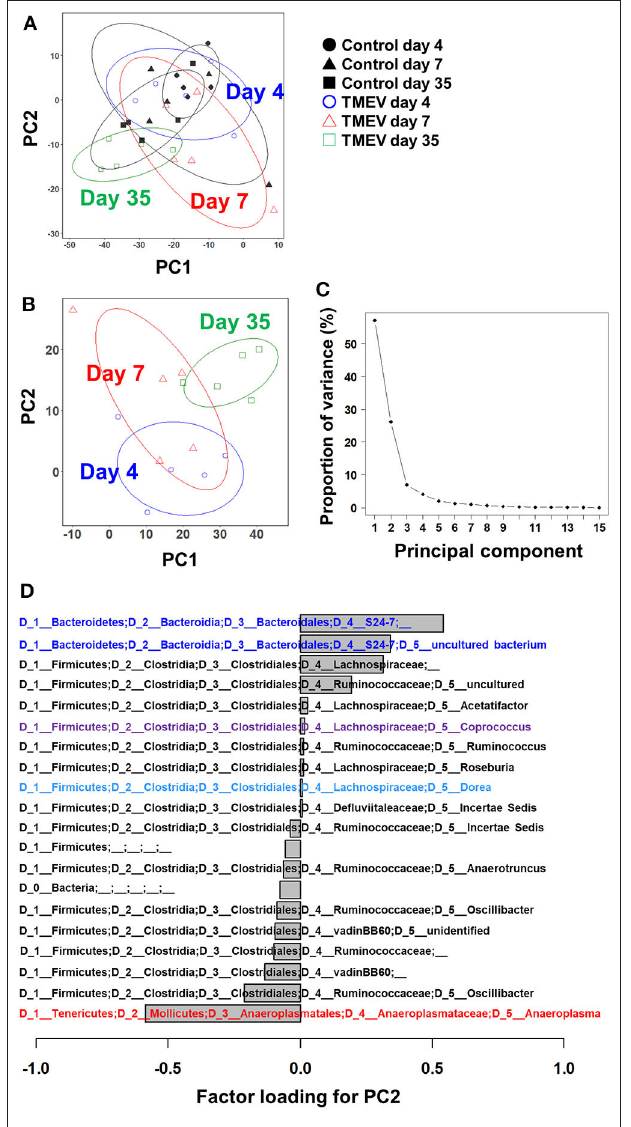
FIGURE 2 | Principal component analysis (PCA) of fecal microbiome data from the TMEV-infected and control groups. (A) When PCA was conducted using all samples from TMEV-infected and control groups on days 4, 7, and 35, PCA did not separate any sample groups as a distinct population, although TMEV-infected group on day 35 had low principal component (PC) 1 and PC2 values. Ellipses indicated an 80% confidence interval of each group. (B) When PCA was conducted using only samples from TMEV-infected groups, PC2 values increased over the time course from day 4 to day 35. (C) Proportion of variance showed that PC1 and PC2 explained 56 and 25% of variance among the samples, respectively. (D) Factor loading showed the correlations between relative abundance of each bacterial taxon to PC2 values. Increased bacteria belong to the family S24-7 and decreased bacteria belong to the genus Anaeroplasma correlated with PC2 values. We conducted PCA of fecal sample data ( n = 5 per group at each time point), using an R function “prcomp.” Graphs with ellipses were drawn, using R packages “dplyr” and “ggplot2”. three indices. In Faith’s phylogenetic diversity index comparing the richness (the number of bacterial genera), we did not find significant differences between the TMEV-infected and